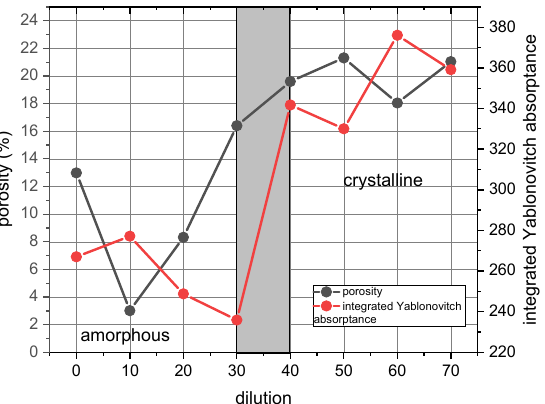
Figure 8. Correlated porosity and the integrated direct Yablonovitch absorptance at the dilutions corresponding to the transition a-Si:H –> μ c-Si:H (grey rectangle).